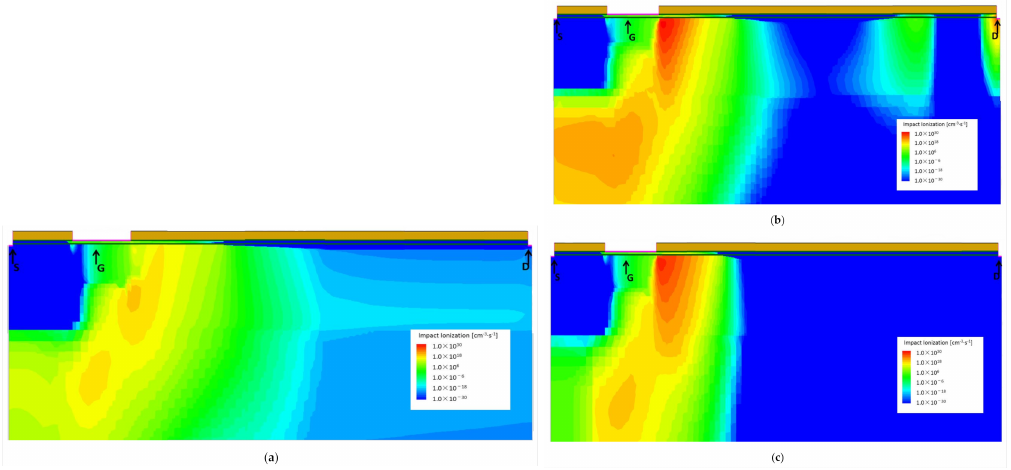
Figure 12. The cross-sections of the impact ionization after the heavy-ion striking at P8: ( a ) before heavy-ion striking, ( b ) 0.05 ns after heavy-ion striking, and ( c ) 50 ns after heavy-ion